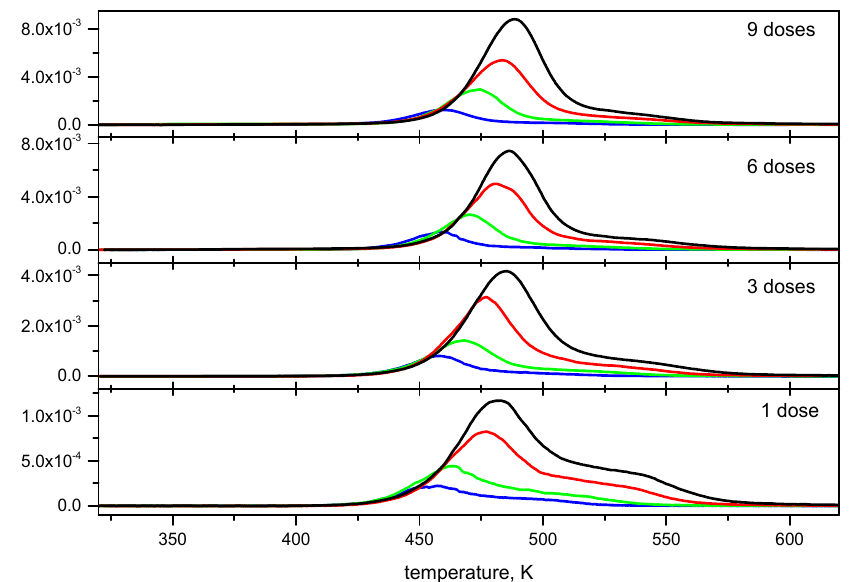
Figure 6. CHA–14 TPSR profiles measured at different heating rates (black curves—15 K · min − 1 ; red curves—10 K · min − 1 ; green curves—5 K · min − 1 ; blue curves—2.5 K · min − 1 ), y-axis is rate of formation of ethylene in µ mol · s − 1 .